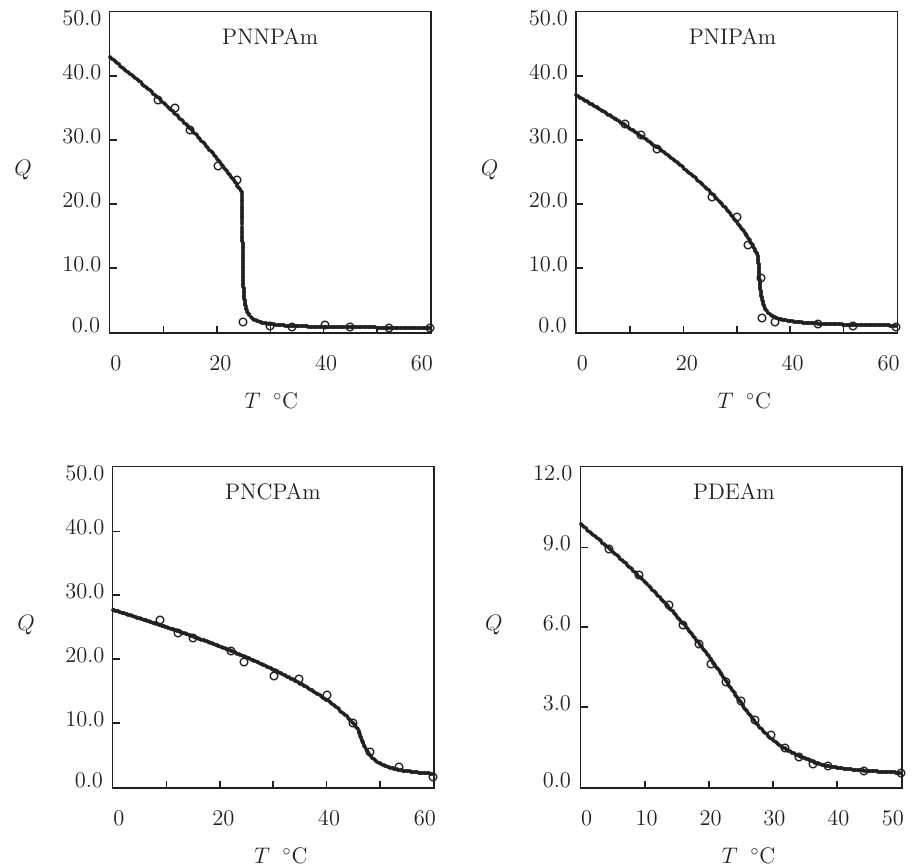
Figure 1. Degree of swelling Q versus temperature T . Circles: experimental data on poly( N , n - propy- lacrylamide) (PNNPAm), poly( N -isopropylacrylamide) (PNIPAm), poly( N -cyclopropylacrylamide) (PNCPAm) [12], and poly( N , N -diethylacrylamide) (PDEAm) [46] gels. Solid lines: results of